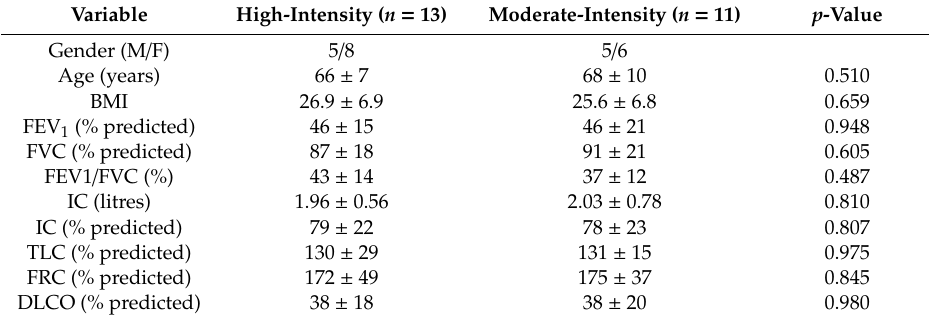
Table 1. Patient demographic characteristics at